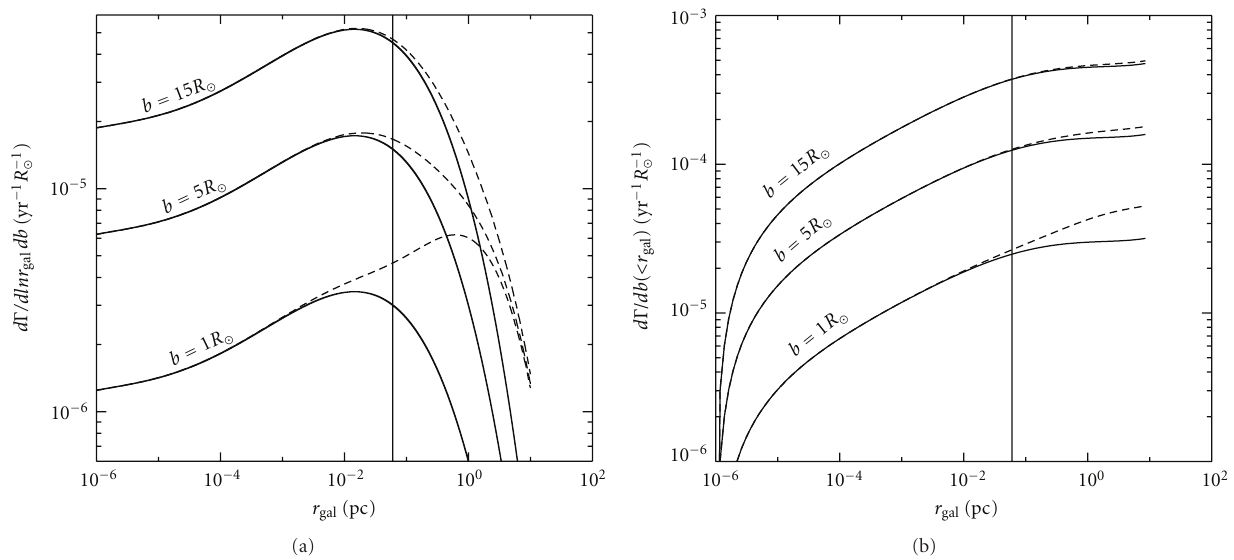
Figure 8: (a) The di ff erential collision rate per logarithmic Galactic radius per impact parameter as a function of Galactic radius for several di ff erent impact parameters. The solid (dashed) lines were calculated ignoring (including) gravitational focusing. The curves were made by made by integrating (16) (with and without the gravitational focusing term) assuming Salpeter values. (b) The cumulative di ff erential collision rate (integrated over r gal ) per impact parameter with and without gravitational focusing for the same impact parameter values. (a), (b) The vertical line in each panel is placed at r gal = 0 . 06pc, the upper bound in our integration across r gal as performed in Section